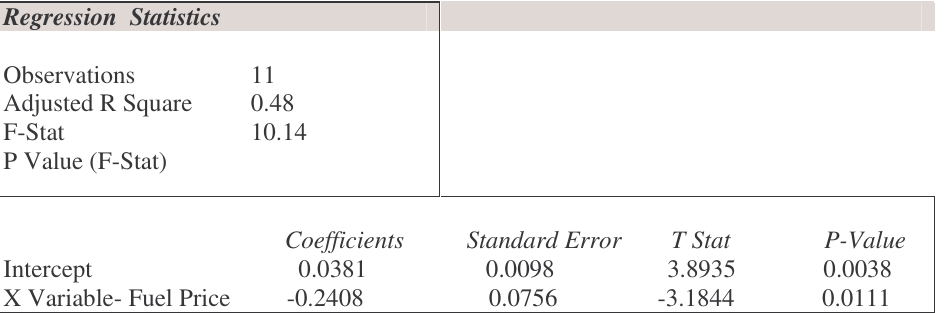
Table 4: Petrol regression analysis Regression